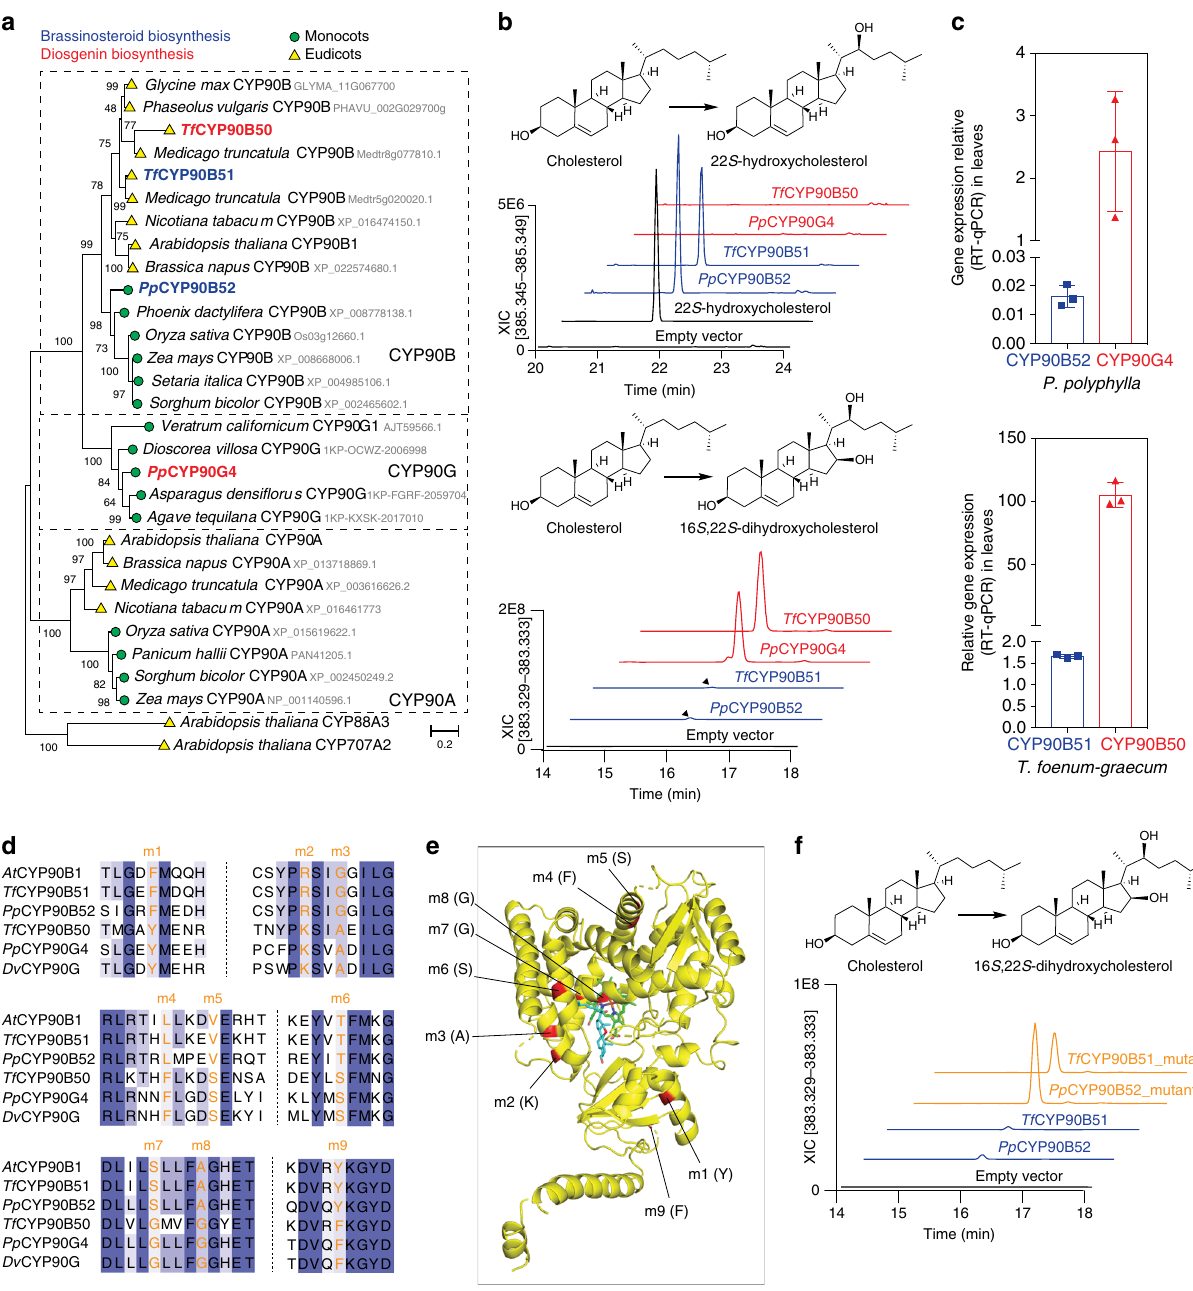
Fig. 5 Parallel evolution of diosgenin-biosynthetic CYP90s in monocots and dicots. a Maximum-likelihood phylogenetic tree of CYP90-family members from various plants, rooted on A. thaliana CYP88A3 and CYP707A2 as the outgroup. Bootstrap values (based on 2000 replicates) are indicated at the tree nodes. The scale measures evolutionary distances in substitutions per amino acid. Protein sequences were retrieved from GenBank or 1KP 56 with their